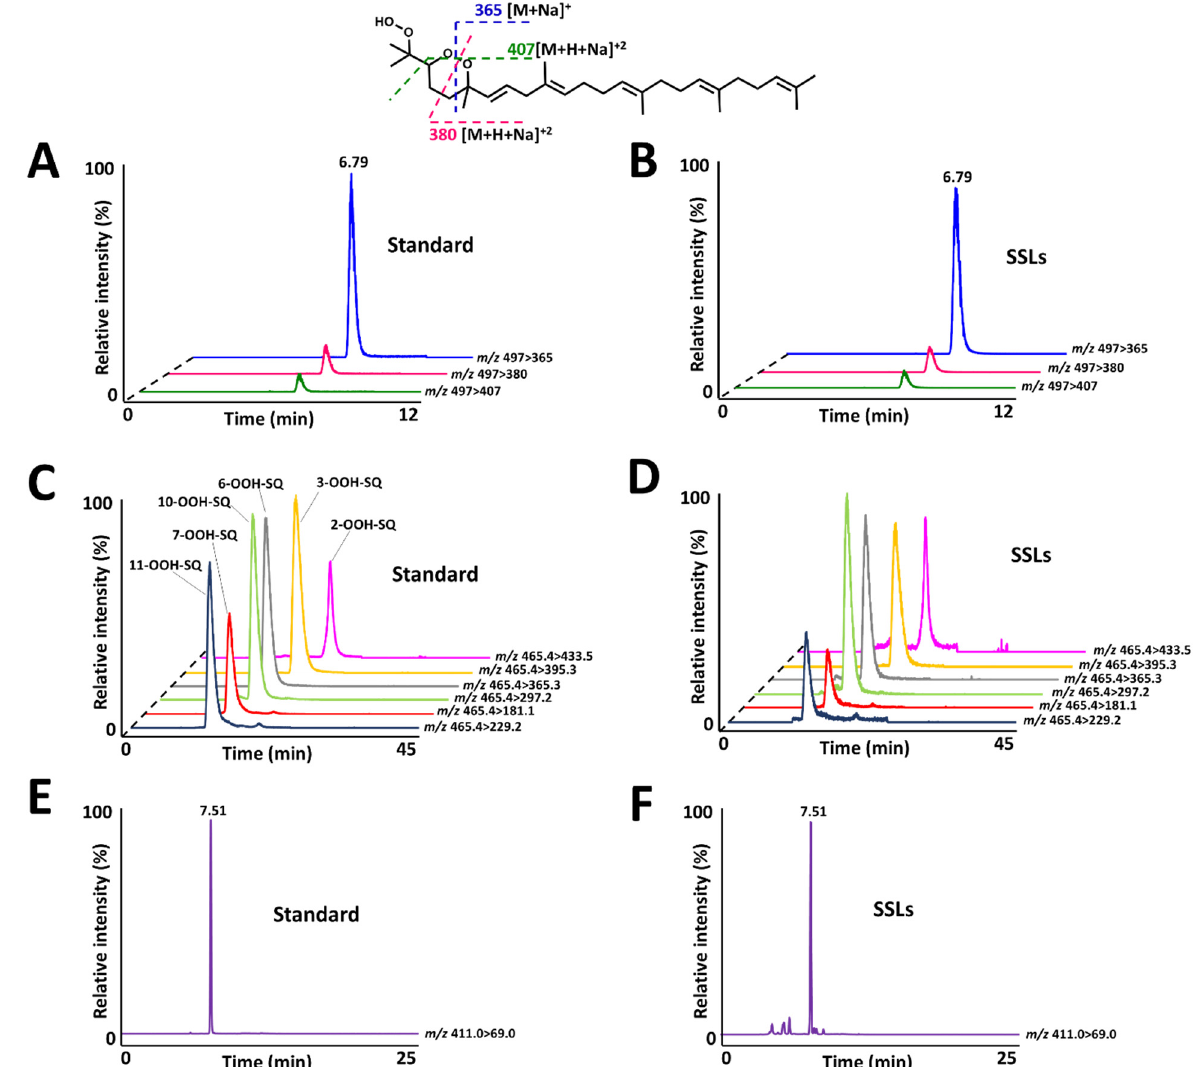
Figure 8. ( A ) 2-OOH-3-(1,2-dioxane)-SQ standard’s chromatogram with characteristic fragments as demonstrated on the structure. ( B ) 2-OOH-3-(1,2-dioxane)-SQ chromatogram from skin surface lipids (SSLs). ( C ) SQ-OOH standards’ chromatogram. ( D ) SQ ‐ OOH chromatogram from SSLs. ( E ) SQ standard’s chromatogram. ( F ) SQ chromatogram from SSLs.